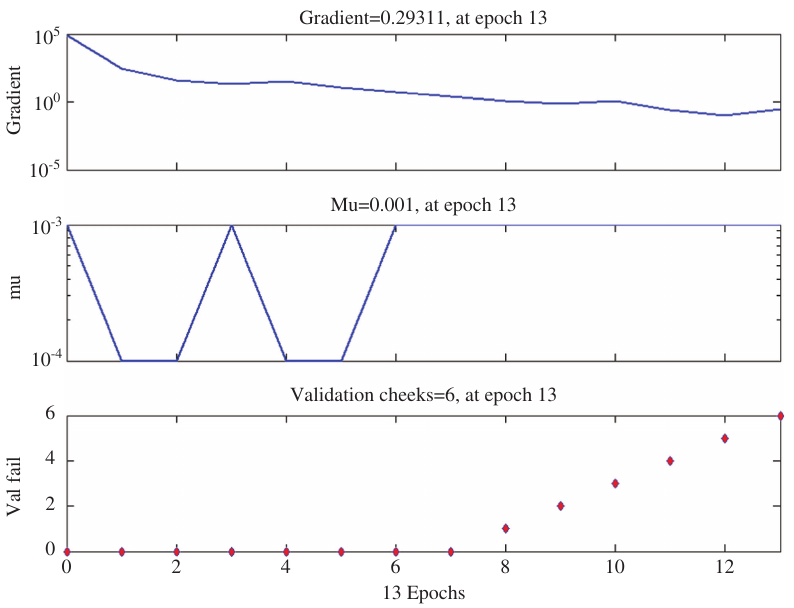
Figure 6 Training state of NN